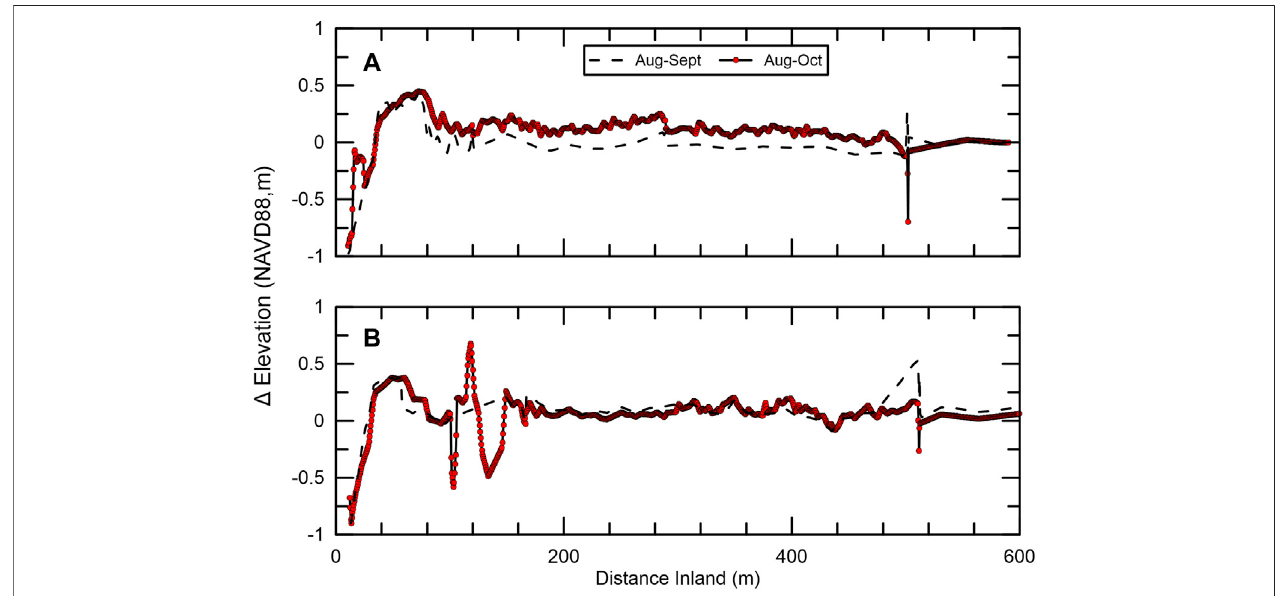
FIGURE 9 | Change in elevation from pre-storm baseline after Hurricanes Laura (Aug-Sept) and Delta (Aug-Oct) for the natural transect (A) and the breakwater transect (B) .